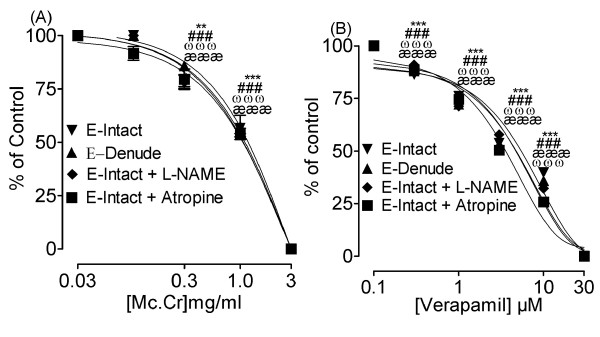
Concentration-response curves showing the vasodilator effect of Mc.Cr (A) and verapamil (B) in the absence and presence of the Nω-nitro-l-arginine methyl ester (L-NAME, 0.1 mM) and atropine (1 μM) and on phenylephrine (PE 1 μM) induced contractions in isolated endothelium-intact and denude rat aorta preparations. **P < 0.01; ***P < 0.001; shows a comparison of concentration-dependent effects(specified effect compared with the effect of preceding dose) on endothelial intact rat aorta, whereas, ωωωP < 0.001; shows a comparison of concentration-dependent effect on endothelial denuded rat aorta and æææP < 0.001; shows a comparison of concentration-dependent effect on L-NAME with endothelial intact rat aorta, ###P < 0.001; shows a comparison of concentration-dependent effect on atropine pre-treatment with endothelial intact rat aorta.